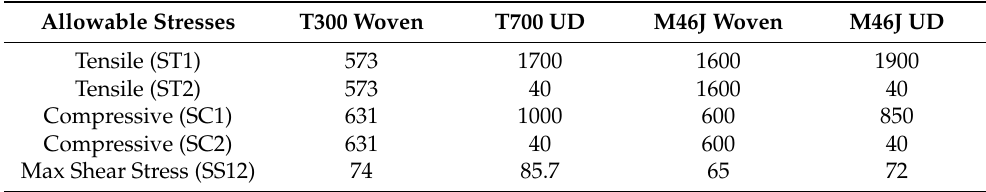
Table 16. Allowable tensile and compressive stresses for each material.